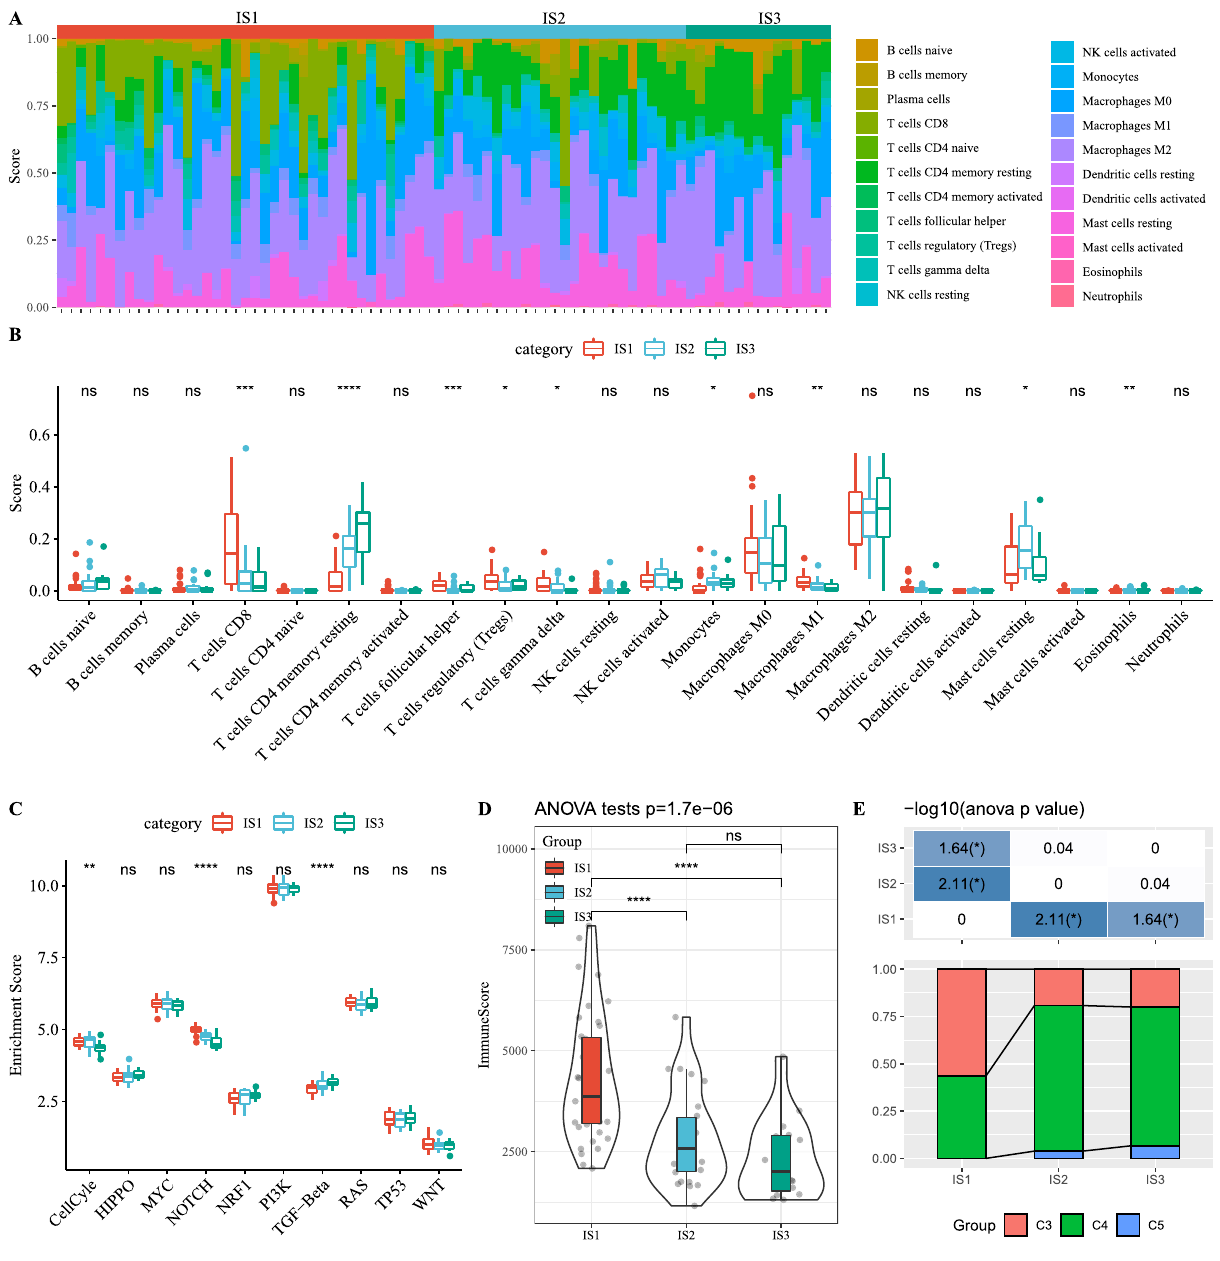
Figure 4. Association between IS and tumor immune microenvironment. ( A ) Heatmap of the degree of immune infiltration of 22 kinds of immune cells in different IS samples. ( B ) Box plots showing the relationships between IS and immune cell infiltrations. ( C ) Enrichment of three ISs in 10 oncogenic pathways. ( D ) Differences in immune scores between the three IS samples. ( E ) Comparison of the distribution of immune subtypes in different ISs. * P < 0.05; ** P < 0.01; *** P < 0.001; **** P < 0.0001; Ns: not